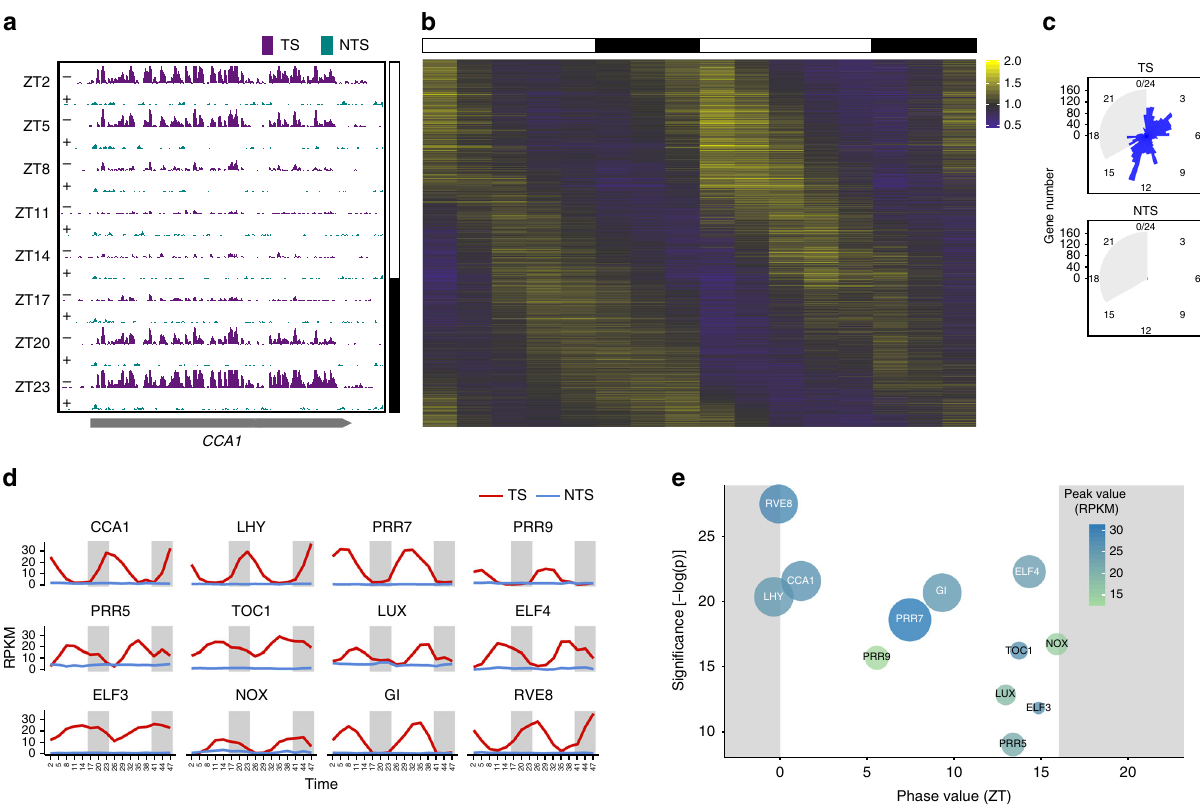
Fig. 3 Circadian oscillation of transcription-coupled repair. a Repair of the of CCA1 TS (purple) and NTS (green) at different circadian time points. b Heat map of the relative repair levels of ~4000 genes showing circadian repair rhythmicity in their transcribed strands. The genes are sorted by their phase values. The value represented is the observed/median repair ratio per gene. c Phase value distribution of the genes having an oscillating repair in their TS (top) and NTS (bottom). The plot is a circularized histogram allowing a fl uent circadian scale. d The circadian repair pro fi les of the core clock genes. The y - axis shows the repair signal (RPKM) whereas x -axis represents time of the concatenated two experiments. The gray background represents the 8 h dark period. e Phase value ( x -axis) vs. – log p value (signi fi cance of rhythmicity computed with Metacycle software, y -axis) pro fi le of the core clock genes. Circle sizes indicate peak-to-trough read amplitudes and color gradient indicates peak